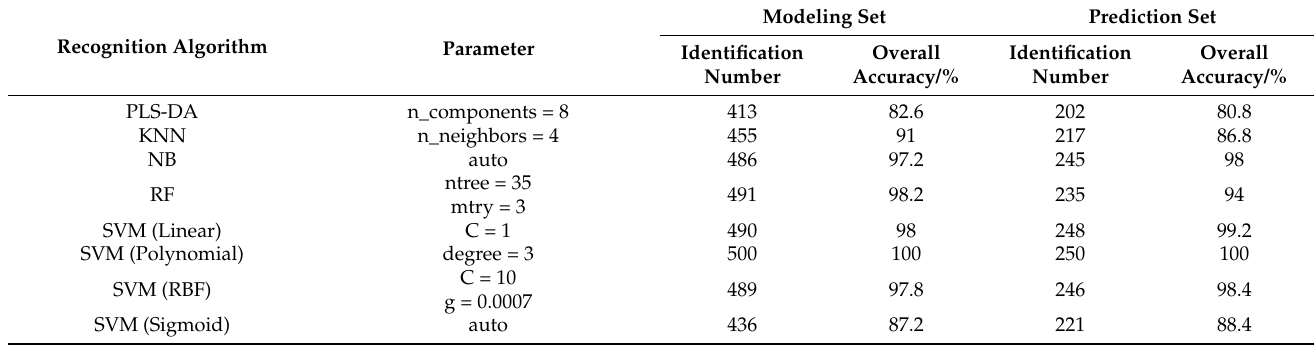
Table 4. The total recognition results of diffident models based on feature wavelengths.